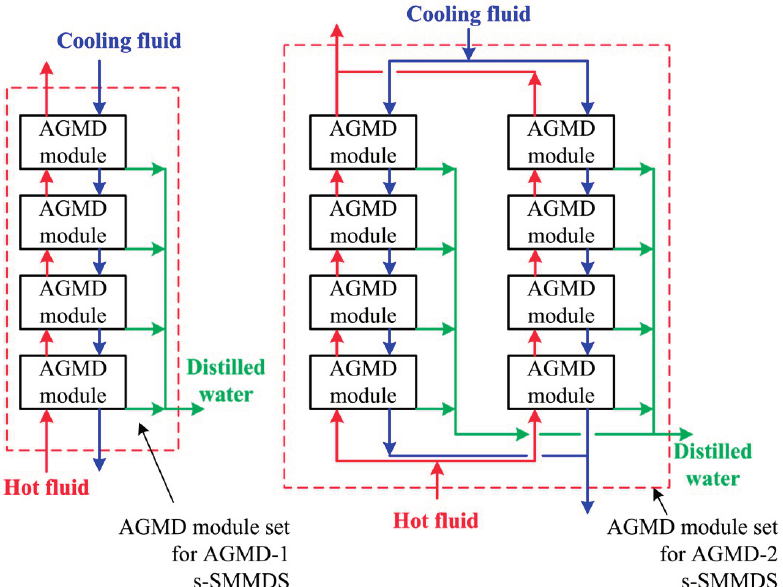
Figure 3. AGMD module arrangements for AGMD-1 and